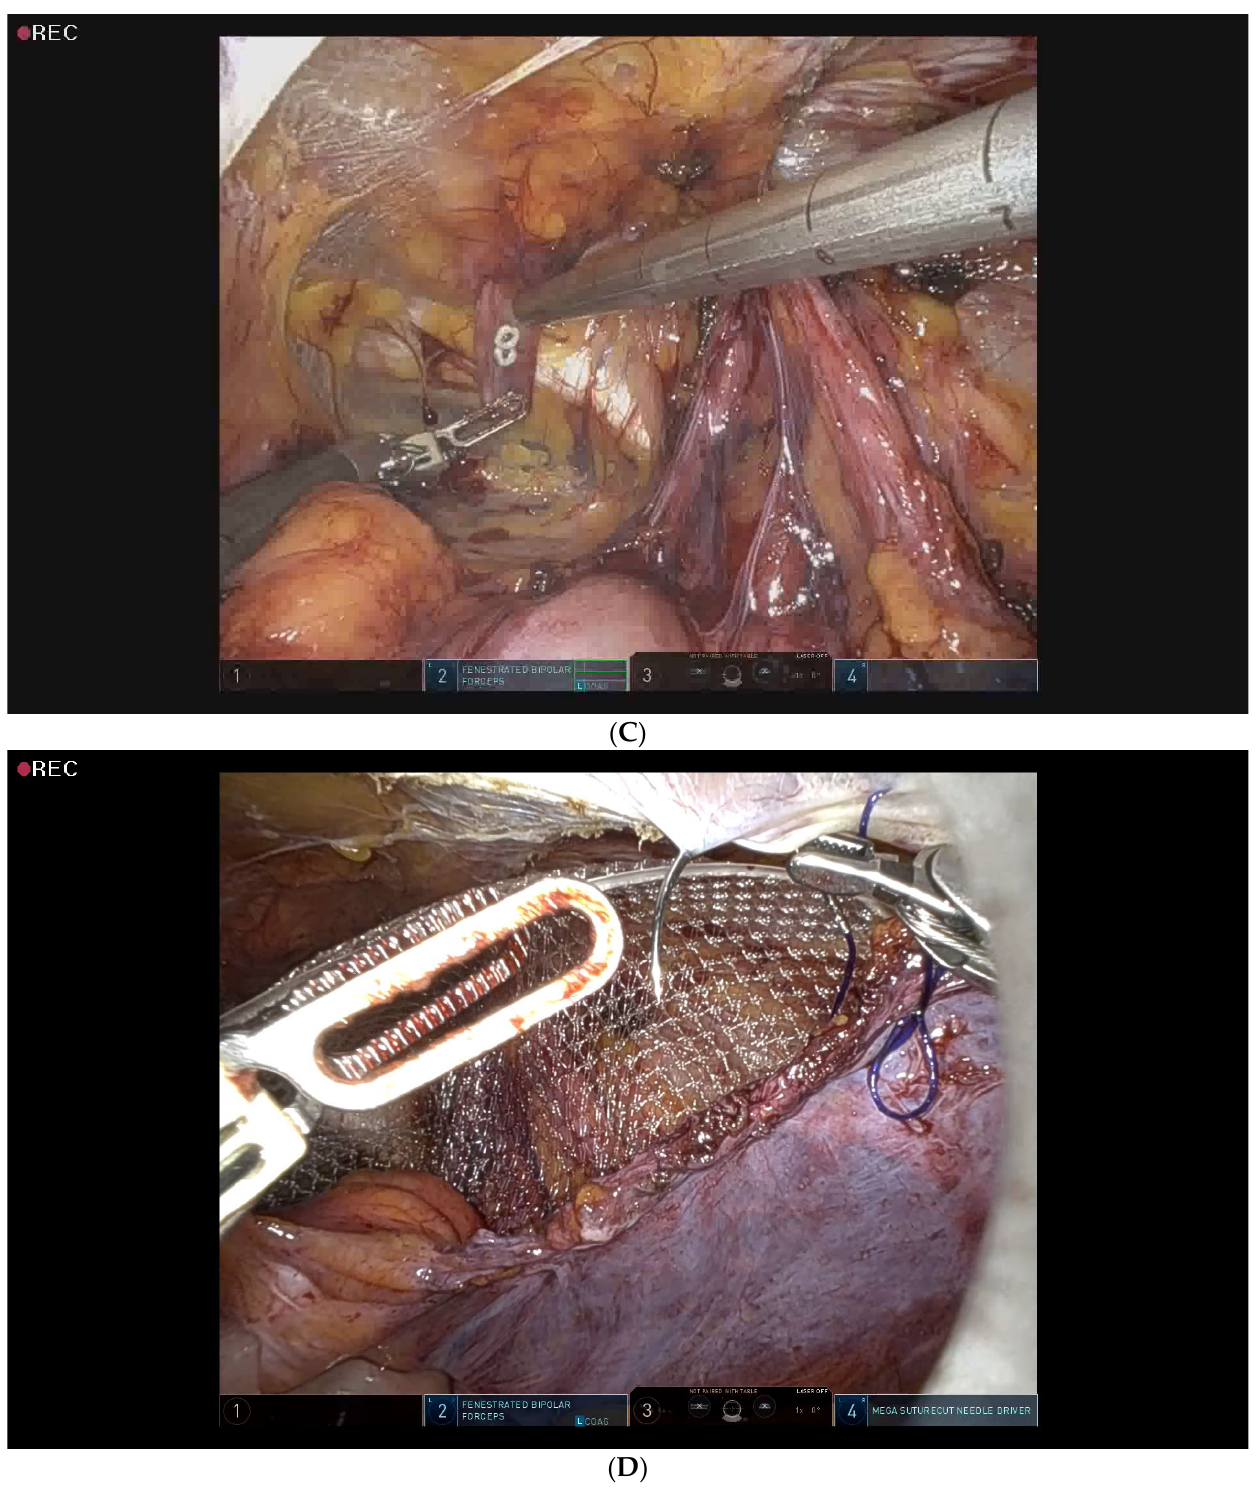
Figure 3. Robotic-assisted TAPP hernia repair procedure. ( A ). Peritoneum dissection using monopolar curved scissors. ( B ). Mesh application using a tack on the pubic bone. ( C ). Hernia sac fixation using a tack on the pubic bone. ( D ). Reperitonization using a robotic arm.